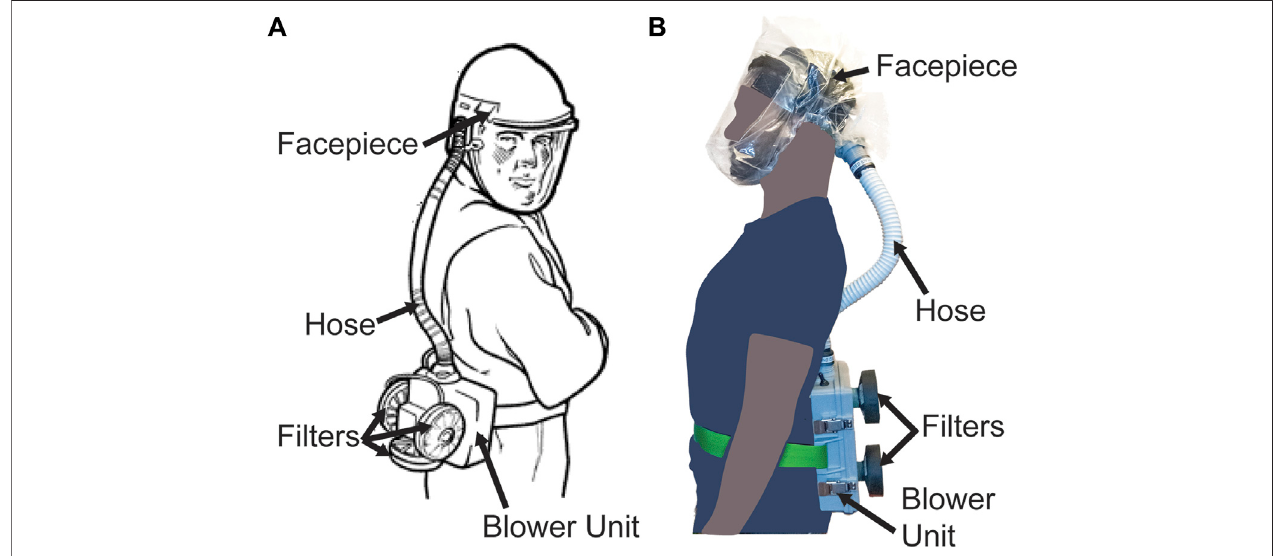
FIGURE1| PAPRcomponents. (A) DiagramofPAPRcomponents,adaptedfromOSHA.gov(OSHATechnicalManual,2006). (B) PanFabPAPRdescribedinthis work.